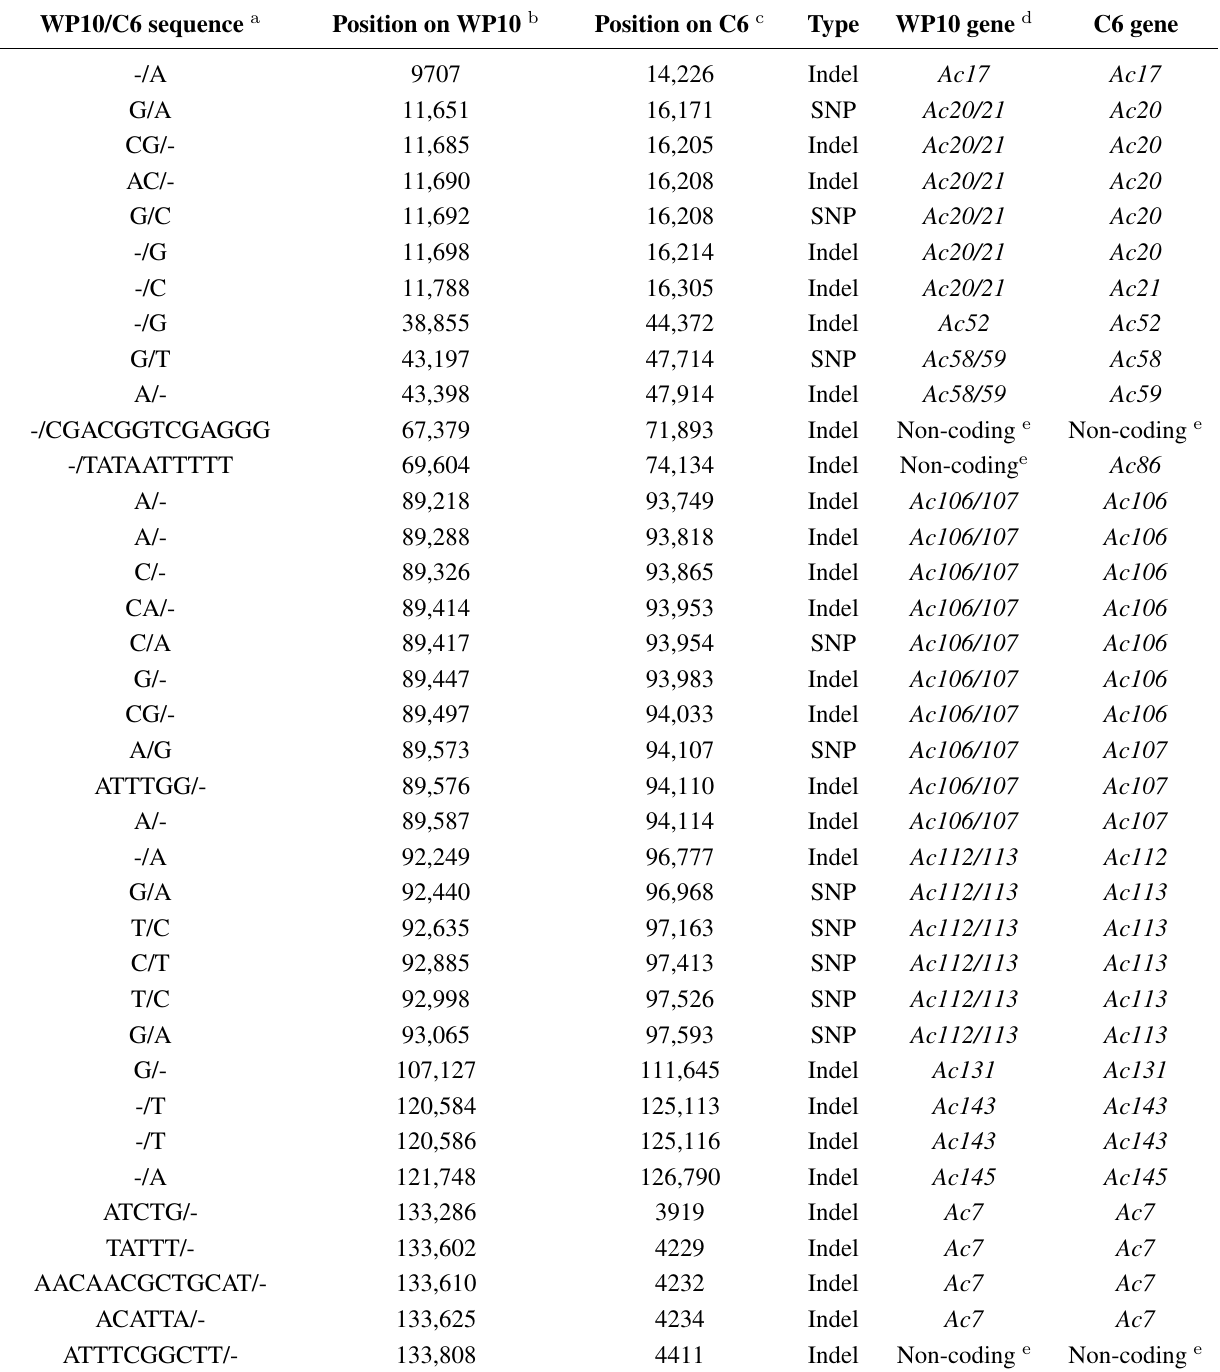
Table 1. Sequence variations observed between AcMNPV-WP10 consensus sequence and AcMNPV-C6